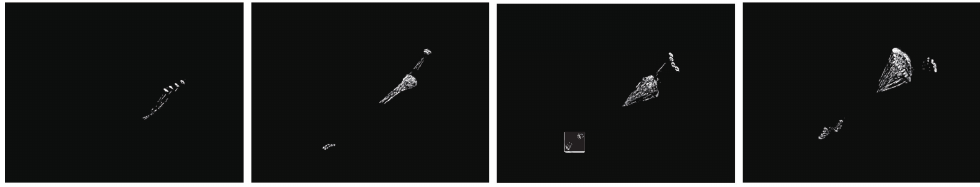
Figure 14. Detecting the pilot chute in the predicted